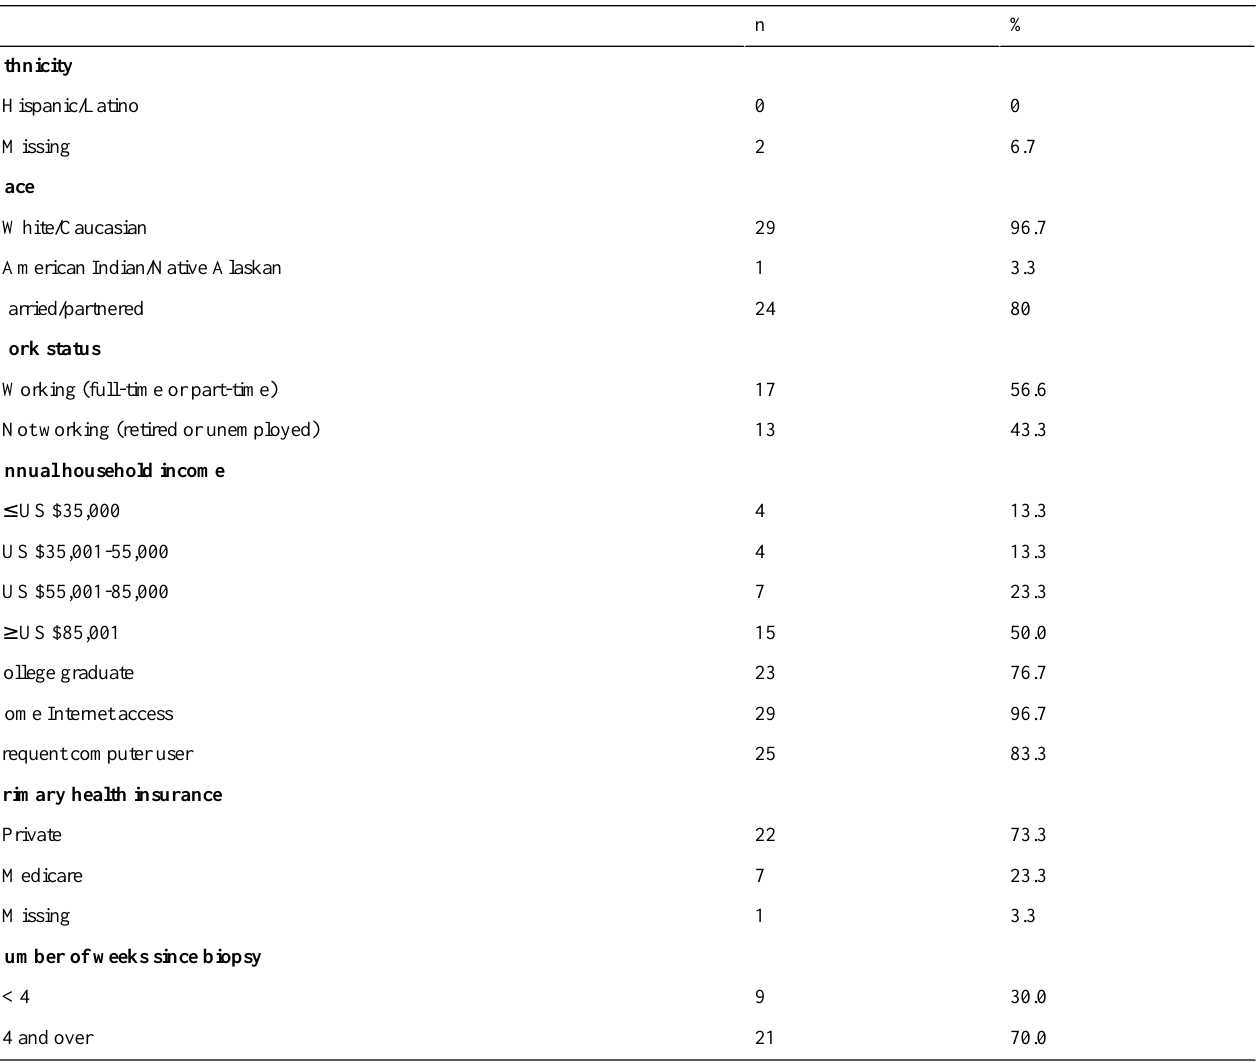
Table 4. Demographic characteristics of participants (N = 30)